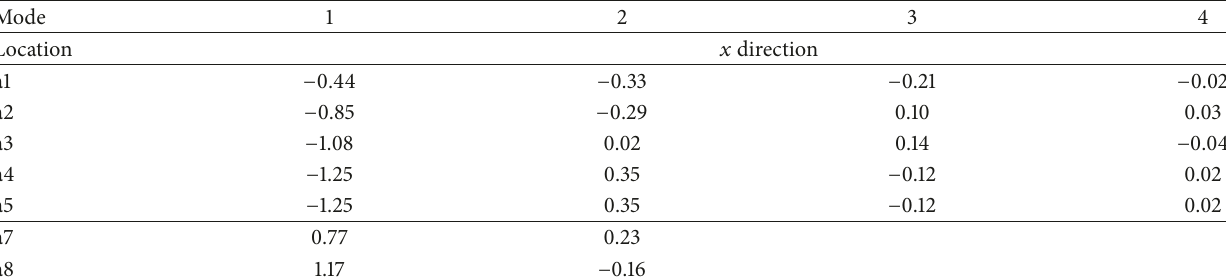
Table 6: Structure A and B FE model seismic eigenvectors.